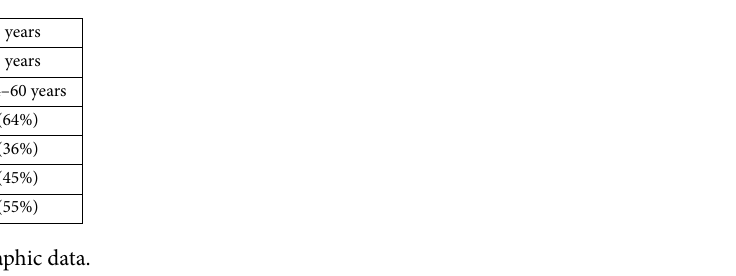
Table 2. Controls: demographic